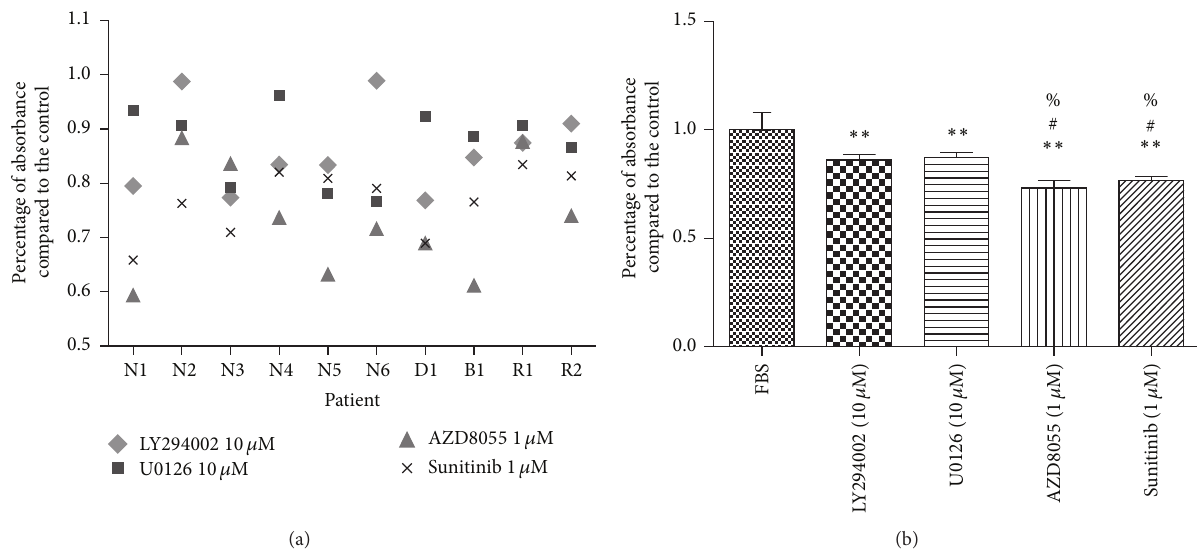
Figure 3: Effect of pathway inhibitors on cell proliferation in human PPGL cells. Experiments were performed in four independent wells for each group ( 𝑛 = 4 ) and repeated in ten PPGLs ( 𝑁 = 10 ). The results were represented in the scatter diagram (a) and column chart (b). ∗∗ 𝑃 < 0.01 versus control group; # 𝑃 < 0.05 versus LY294002 group; % 𝑃 < 0.05 versus U0126 group. N: PPGL without gene mutation of SDHB, SDHC, SDHD, VHL, and RET; B: PPGL with SDHB mutation; D: PPGL with SDHD mutation; R: PPGL with RET mutation.